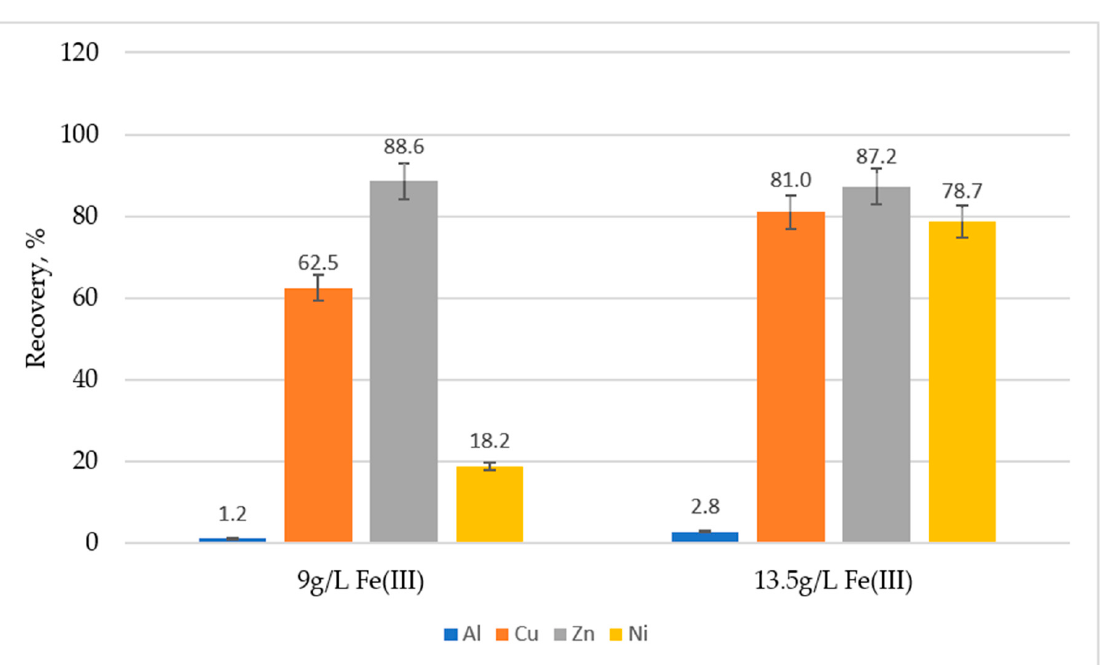
Figure 2. Recovery of metals from PCBs at various concentrations of biogenic Fe 3+ (PD 1%; initial pH 1–1.1; 40 °C; air 1 lpm; 600 rpm; duration 24 h).